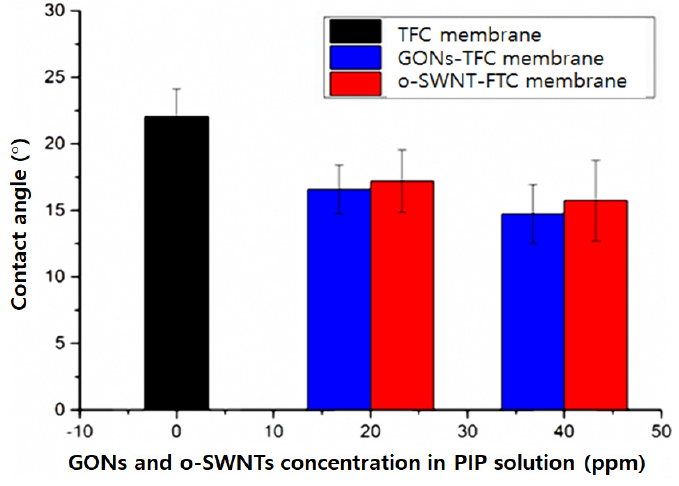
Figure 3. Contact angle of TFC, GONs-TFC, and o-SWNTs-TFC membranes ( n = 8).